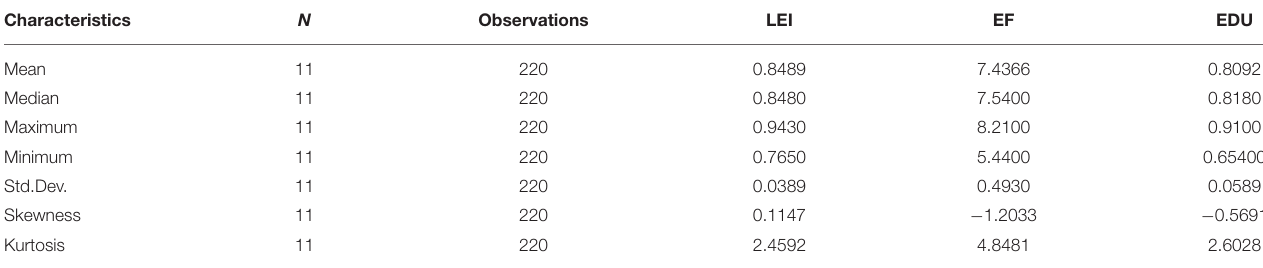
TABLE 2 | Descriptive statistics of the dataset.